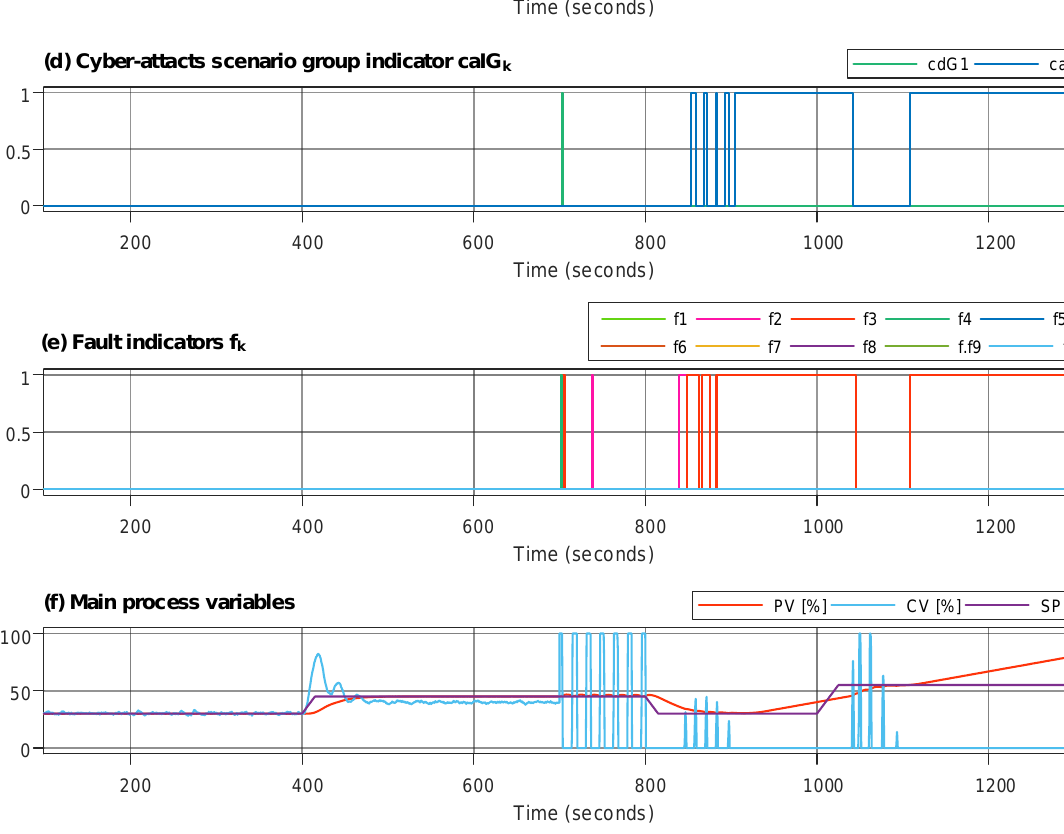
Figure 5. An example of the detection of a cyber-attack cas 2 : ( a ) residual values, ( b ) values of diagnostic signals, ( c ) signal of cyber-attack detection, ( d ) indicators of location of groups of cyber-attacks scenarios, ( e ) indicators of process failures (signals f 1 and f 5 . . . f 10 overlap and have the value of ‘0’, signals f 4 and f 2 have the value “1” only on the beginning of cyber-attack), ( f ) main process